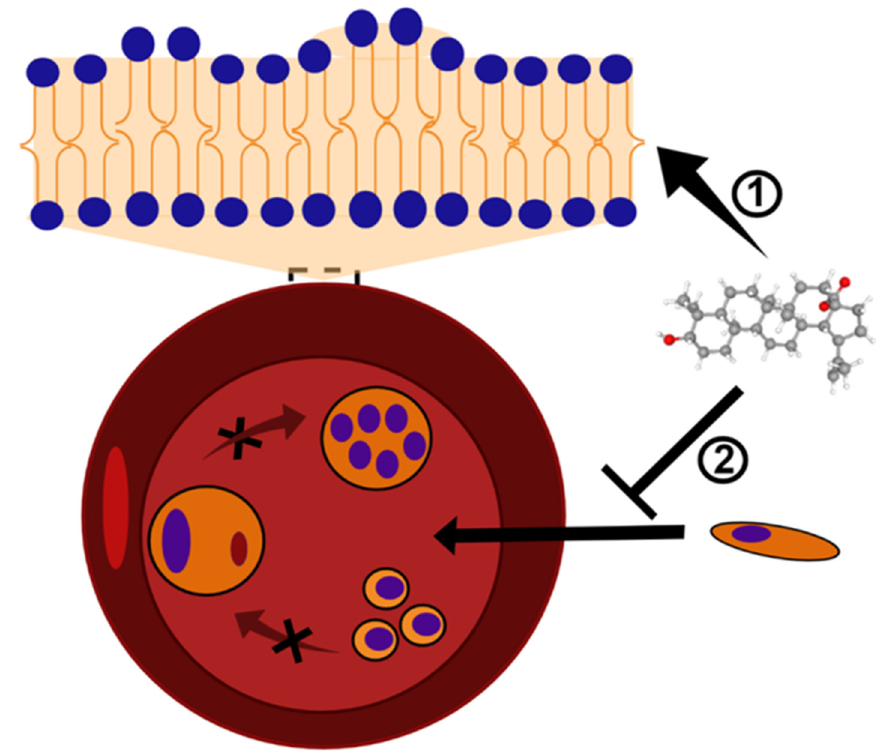
Figure 2. BA and analogs may cause deformation in the lipid bilayer and, consequently, alterations in the erythrocyte shape. This mechanism of action results in the formation of echinocytes or stomatocytes structures (1), and inhibits the Plasmodium invasion and growth (2). The black X symbol represents a blockage of Plasmodium maturation into erythrocytes. BA structure (CID 64971) was obtained from PubChem [81].